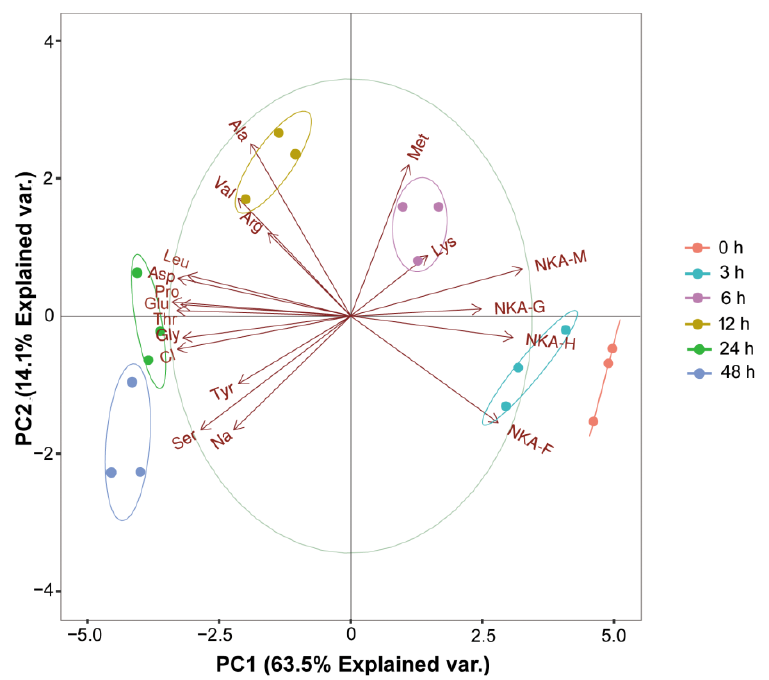
Figure 5. PCA analysis of indicators with a significant difference among groups. NKA-G: NKA activity in the gill; NKA-M: NKA activity in the adductor muscle; NKA-F: NKA activity in the axe foot; NKA-H: NKA activity in the hepatopancreas; Lys: lysine; Leu: leucine; Asp: aspartate; Pro: proline; Glu: glutamine; Thr: threonine; Tyr: tyrosine; Ser: serine; Gly: glycine; Arg: arginine; Val: valine; Ala: Alanine ; Met: methionine.